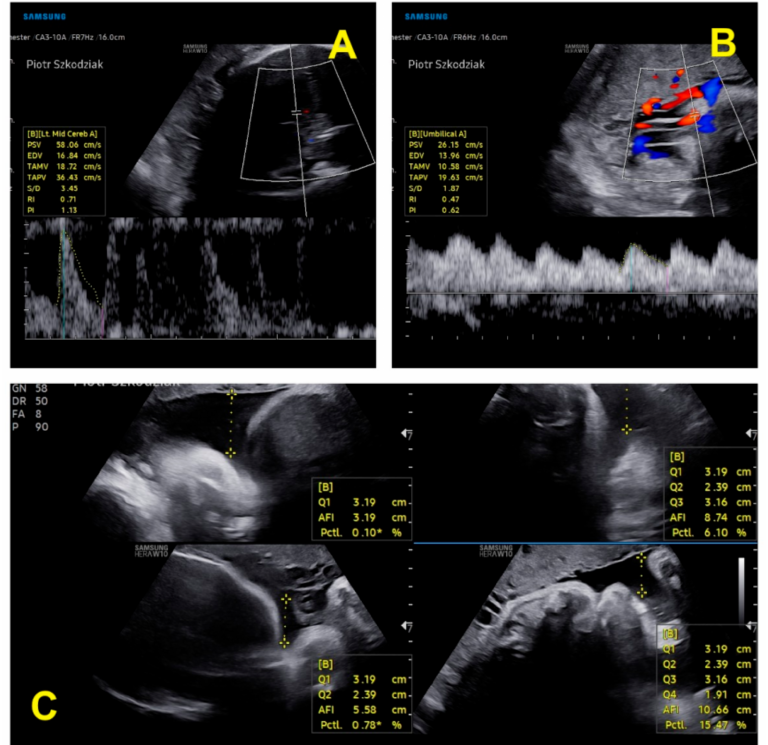
Figure 3. Ultrasound parameters of the first twin’s well-being: ( A ) assessment of blood flow in the MCA; ( B ) assessment of blood flow in the UA; ( C ) amniotic fluid index